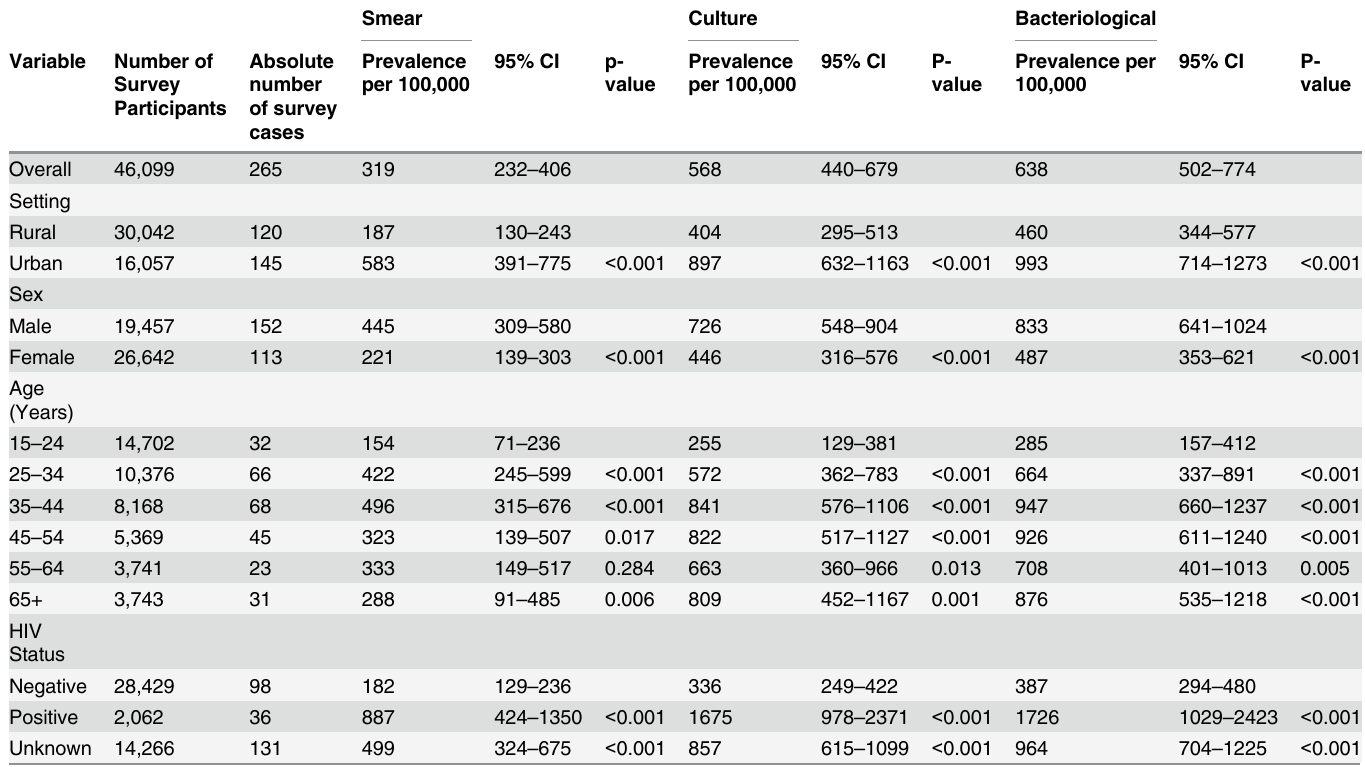
Table 3. Smear, Culture and Bacteriological confirmed TB